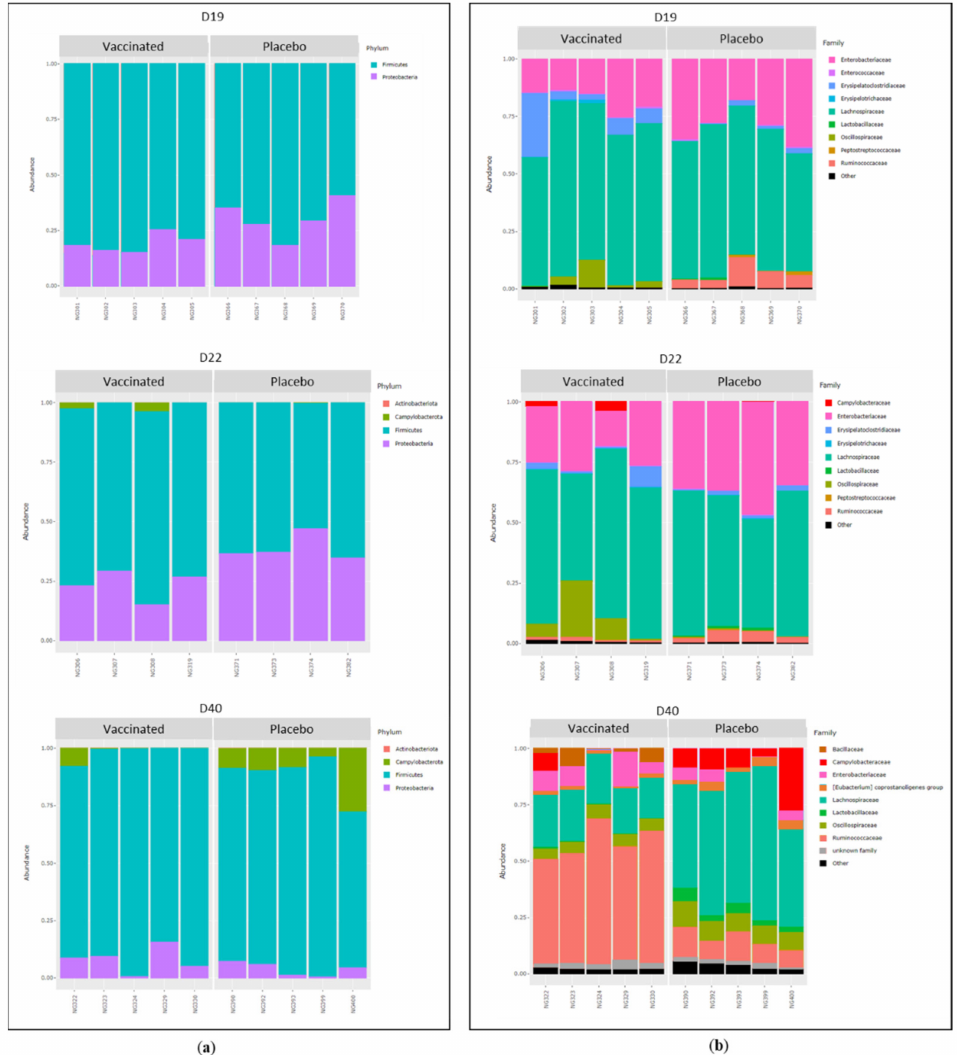
Figure 7. Taxonomic composition represented by relative abundance of bacterial communities from the caecal microbiota of chickens from the vaccinated (v) and placebo (p) groups on D19, D22 and D40. ( a ) Relative abundance of phyla identified in caecal microbiota represented by a bar for each sample. ( b ) Relative abundance of the nine main families represented by a bar for each